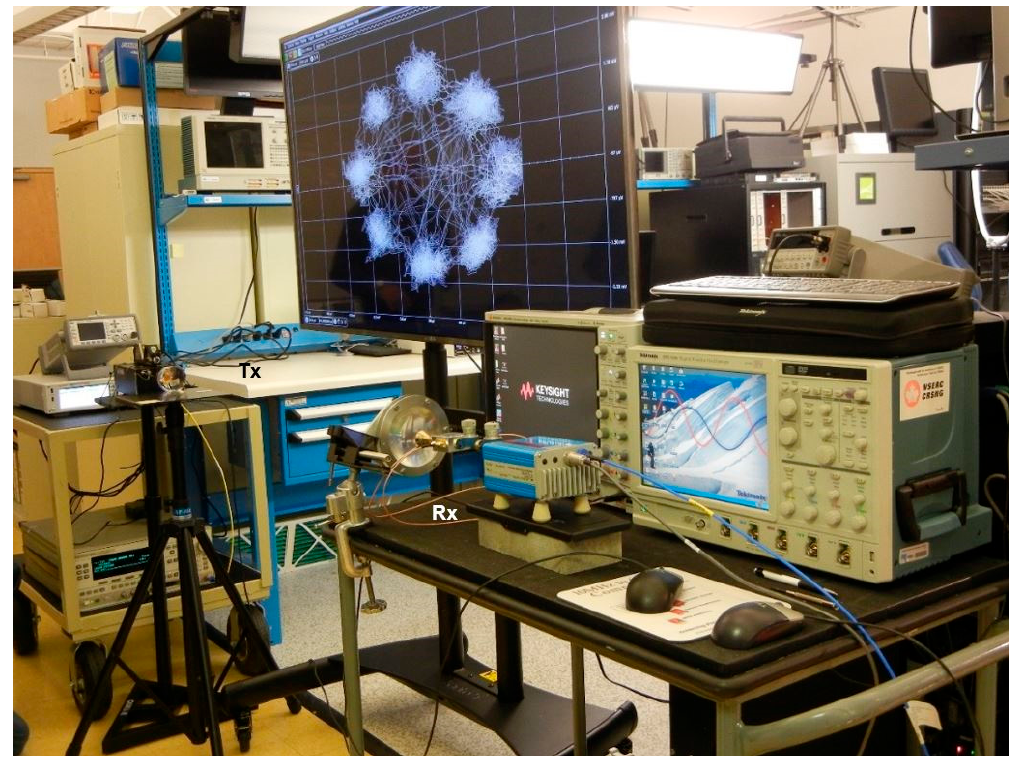
Figure 40. V-band multi-port characterization test-bench using modulated signals.